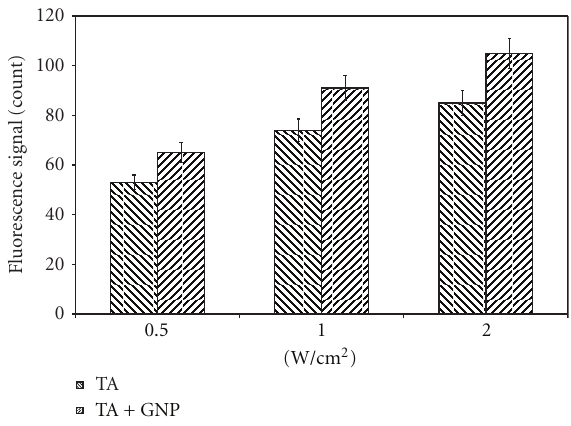
Figure 3: Recorded fluorescence signal intensity in the TA solutions in the absence and presence of GNPs at 0.5, 1, and 2 W/cm 2 intensities in continuous mode, excitation wavelength = 310nm, and emission and excitation band width = 5nm.